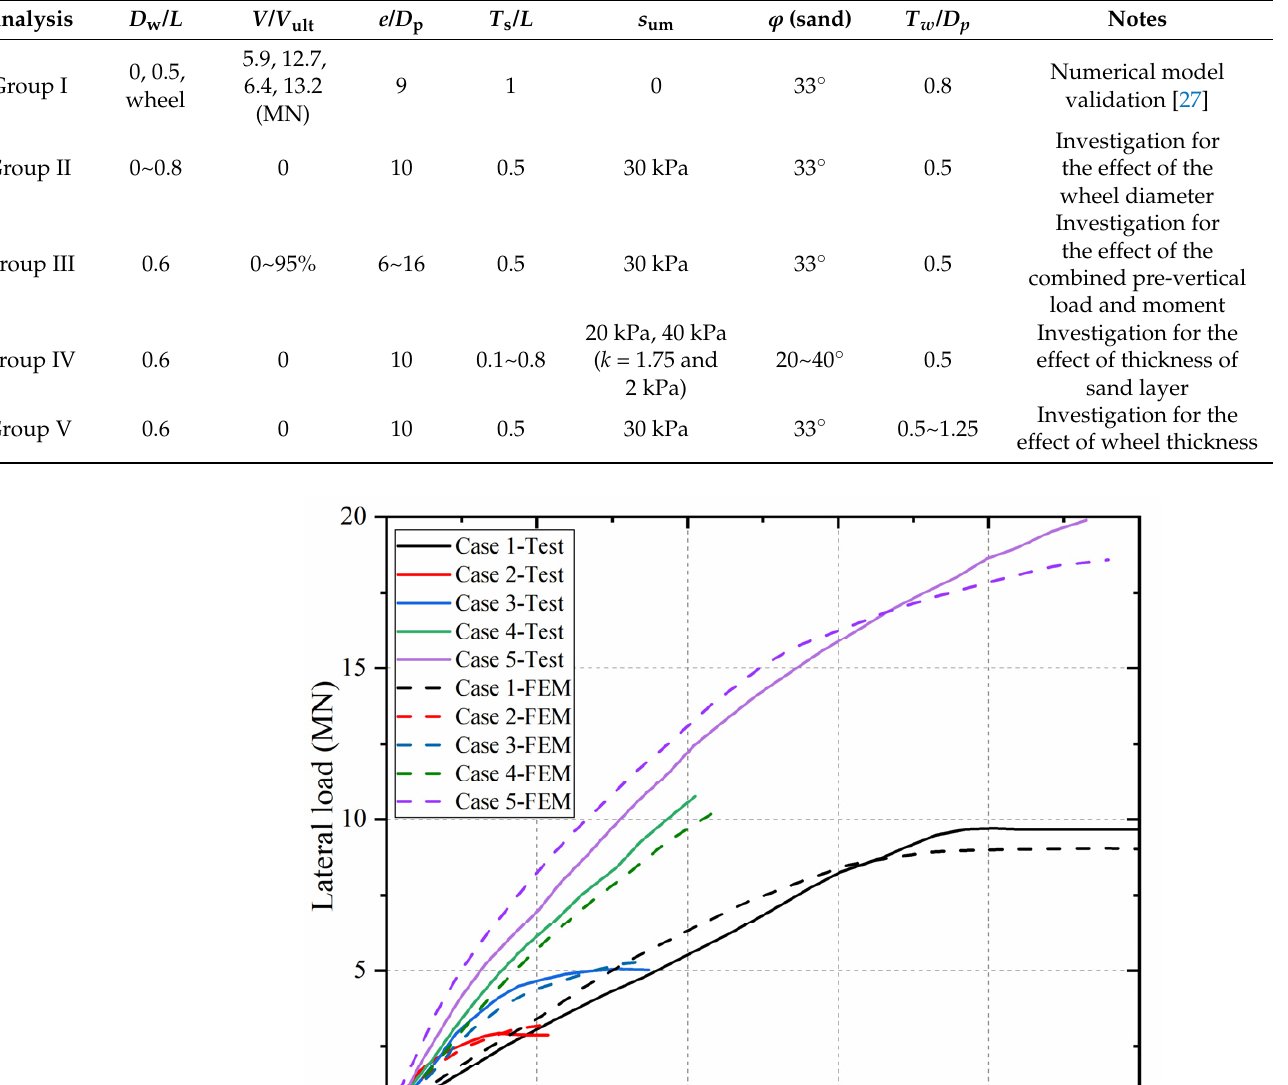
Table 1. Summary of the numerical simulations.